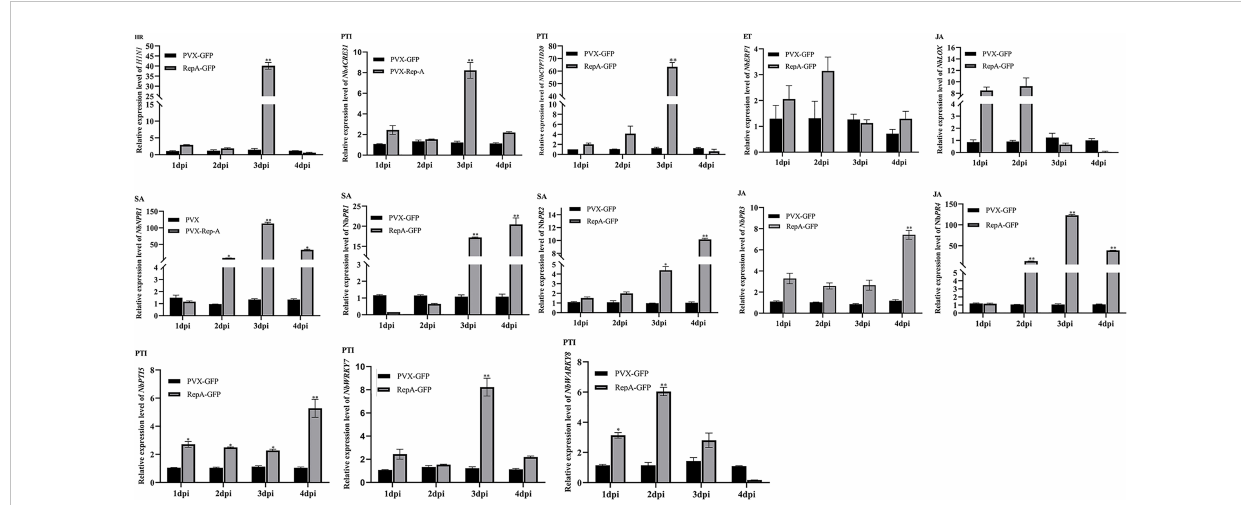
FIGURE 4 Changes in the expression level of defense-related genes in Nicotiana benthamiana leaves inoculated with PVX-GFP or RepA-GFP. NbACTIN was used as the housekeeping gene. The expression of each gene was quanti fi ed using the 2 − DD Ct method. Statistical differences were calculated with the Student ’ s t-test, where * p < 0.05 and ** p < 0.01. The experiment was repeated using four independent biological replicates and four technical